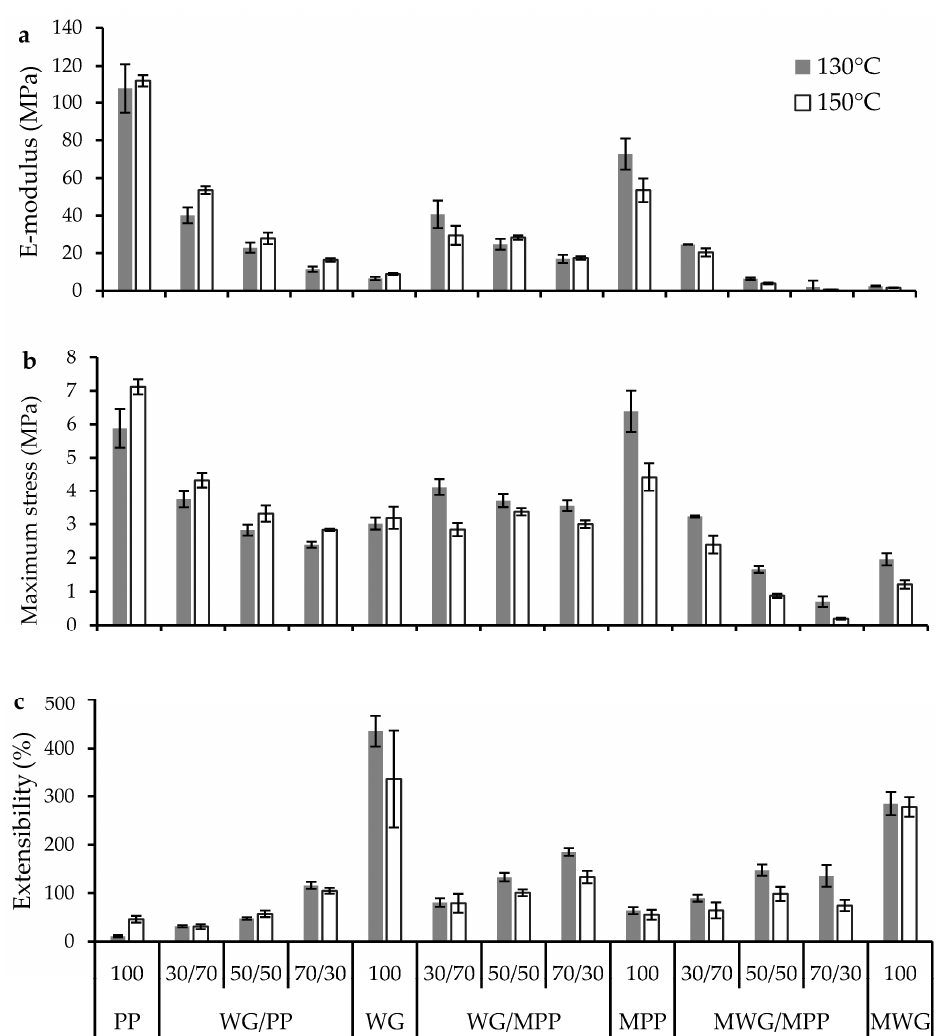
Figure 4. Representation of the range of colors of films and composites MWG100, WG/MPP 70/30, WG/MPP 30/70 and MPP100 pressed at 130 °C.